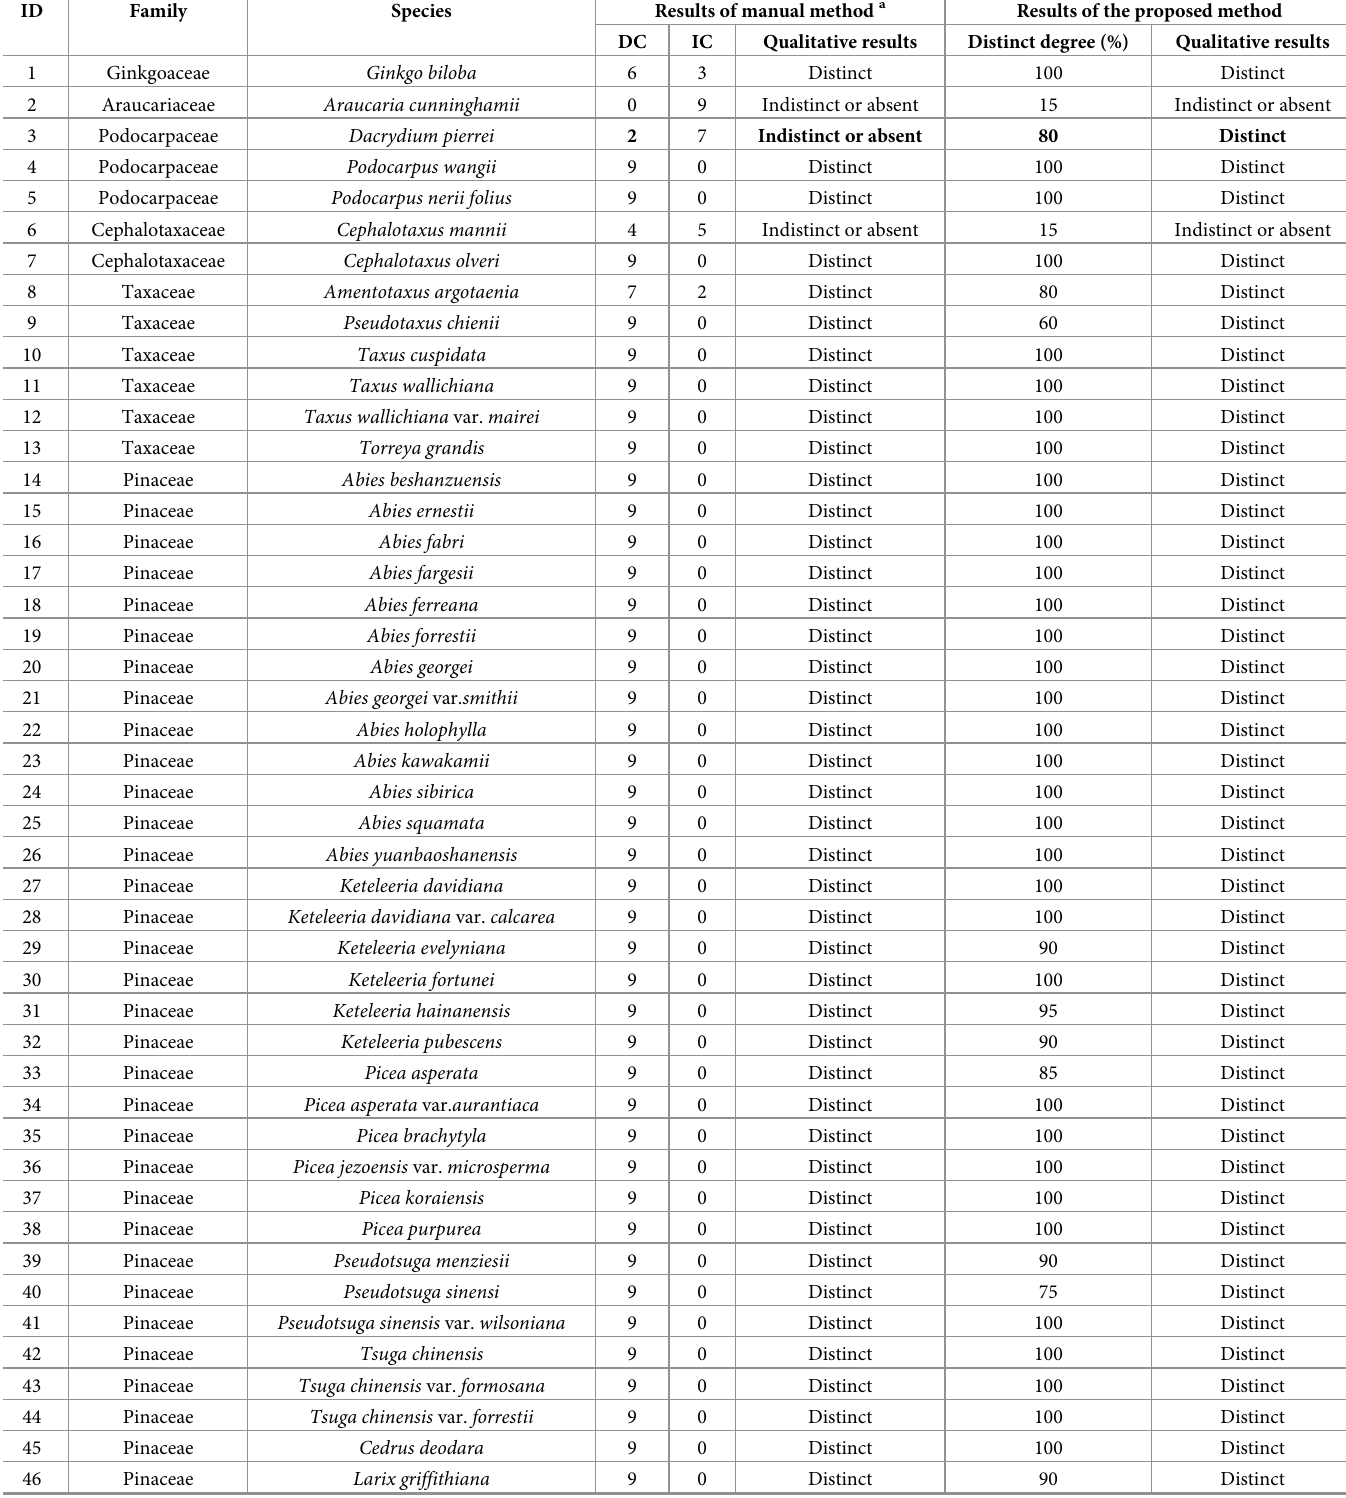
Table 1. The experimental results of 100 softwood